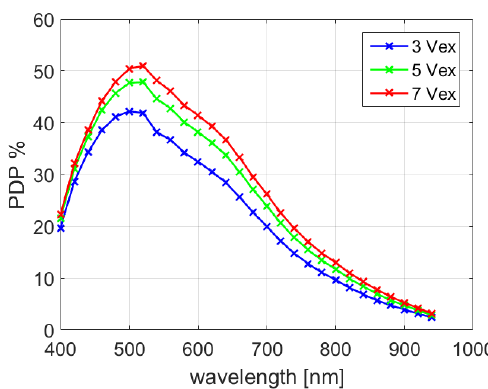
Figure 10. PDP measurement at excess bias voltage of 3 V, 5 V and 7 V.